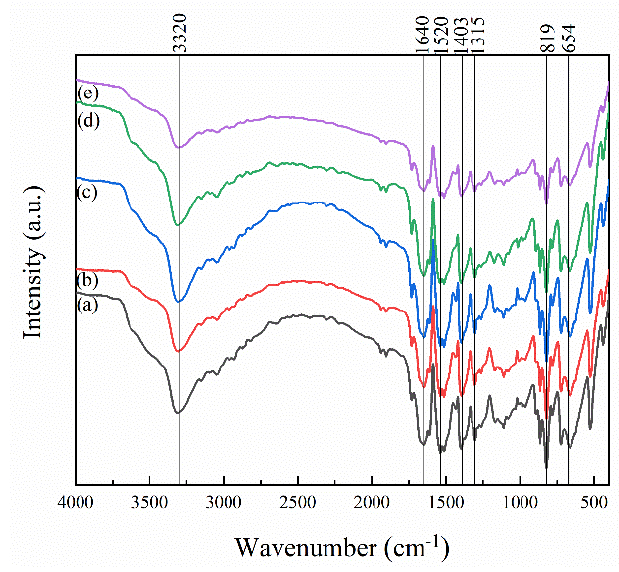
Figure 8. FT-IR spectra of Kevlar fiber before ( a ), and after ozone exposure to atomic oxygen for 100 h ( b ), 300 h ( c ), 500 h ( d ), 1000 h ( e ).